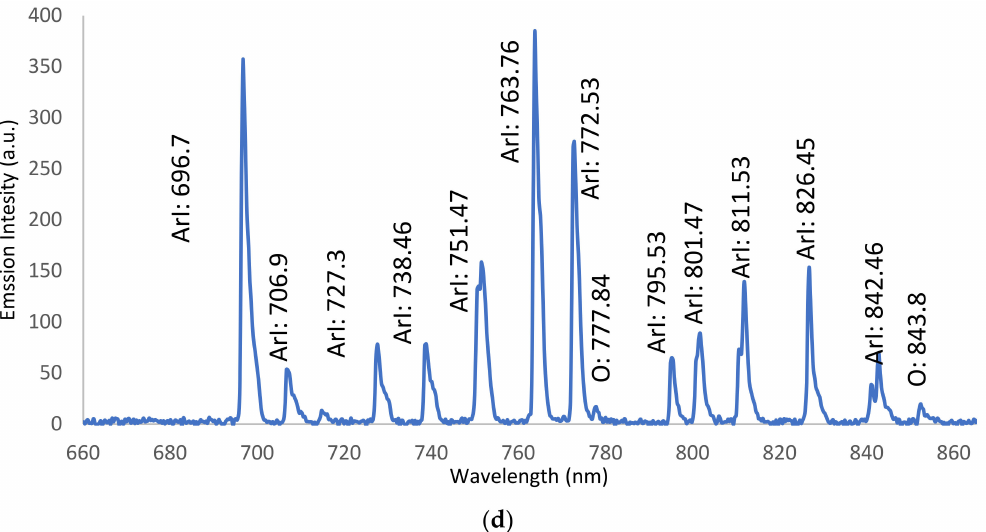
Figure 4. ( a ). Intensity of emission spectra versus wavelength for dry argon discharge. ( b ) Intensity of emission spectra versus wavelength for the hydroxide band. ( c ) Intensity of emission spectra versus wavelength for nitrogen bands. ( d ) Intensity of emission spectra versus wavelength for argon with oxygen line.